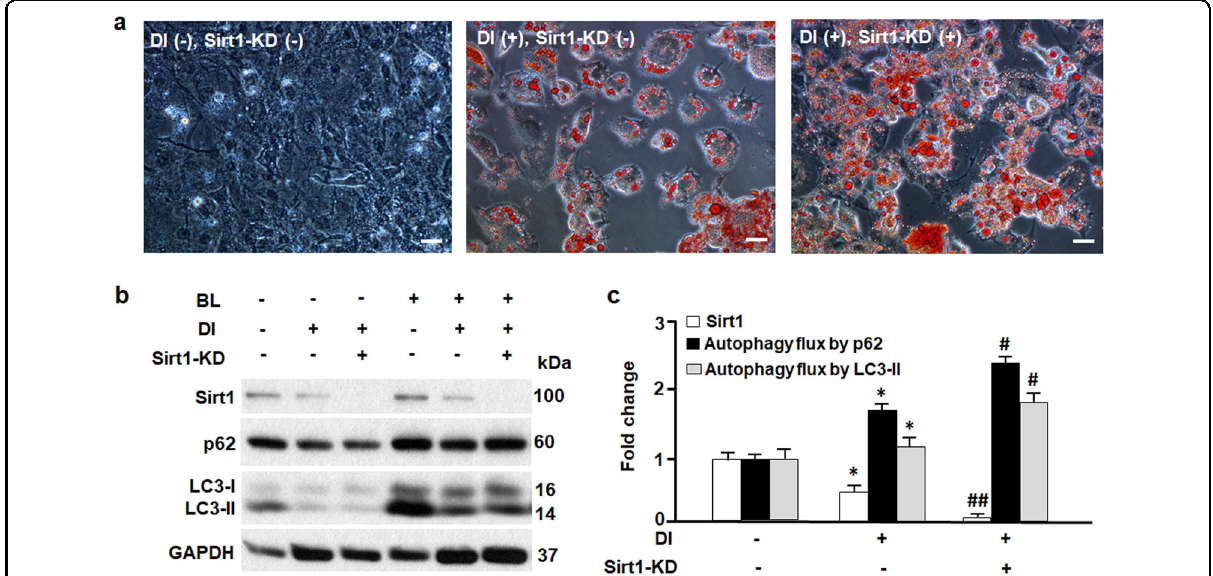
Fig. 3 The effects of loss of Sirt1 on autophagy and adipogenesis. a Oil red O staining of 3T3L1 cells on day 9, in the absence ( − ) or presence ( + ) of differentiation inducer (DI) and Sirt1 knock-down (Sirt1-KD). Scale bar, 100 µm. b Western blotting analysis of Sirt1, p62, and LC3 proteins. GAPDH was probed as a loading control. Autophagy inhibitors ba fi lomycin A1 at 0.1 μ M and leupeptin at 10 μ g/ml (BL) were used to treat the cells and measure the turnover of autophagic substrates p62 and LC3-II (i.e., autophagy fl ux activities). c Densitometric analyses of Sirt1 and autophagy fl ux. Comparing DI( − )Sirt1-KD( − ) with DI( + )Sirt1-KD( − ): * p < 0.05. Comparing DI( + )Sirt1-KD( − ) with DI( + )Sirt1-KD( + ): # p < 0.05; ## p < 0.01. n =